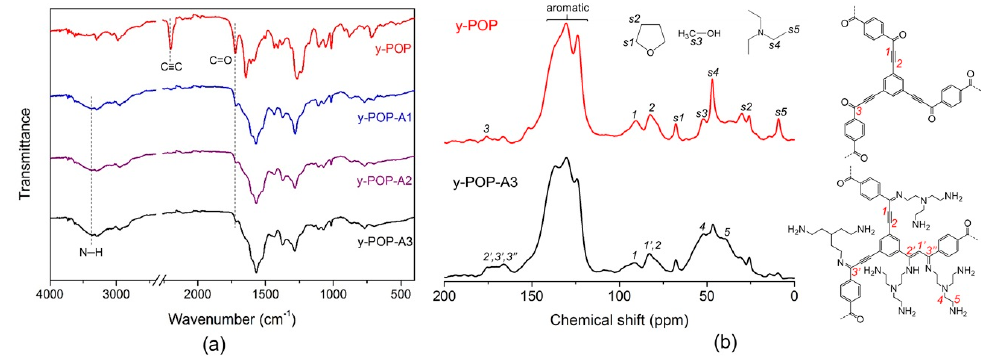
Figure 1. ( a ) Infrared (IR) and ( b ) 13 C nuclear magnetic resonance (NMR) spectra of ynone-linked porous organic polymer (y-POP) and y-POP-NH 2